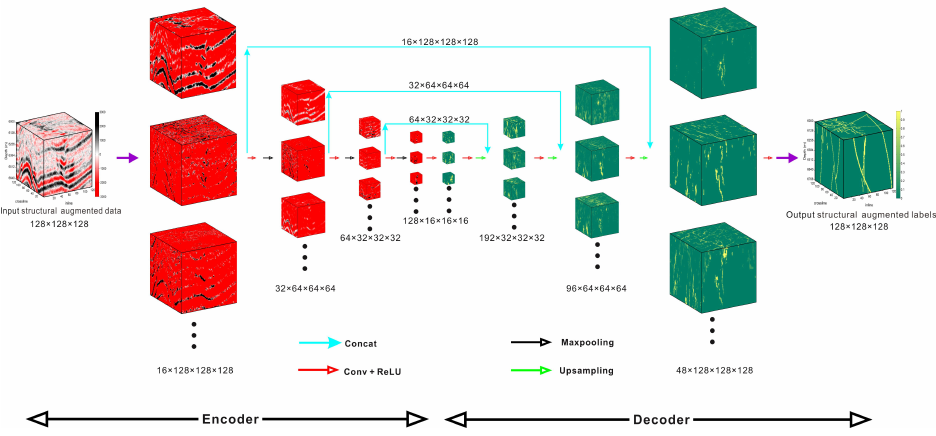
Figure 8. A deep convolutional neural network for fault